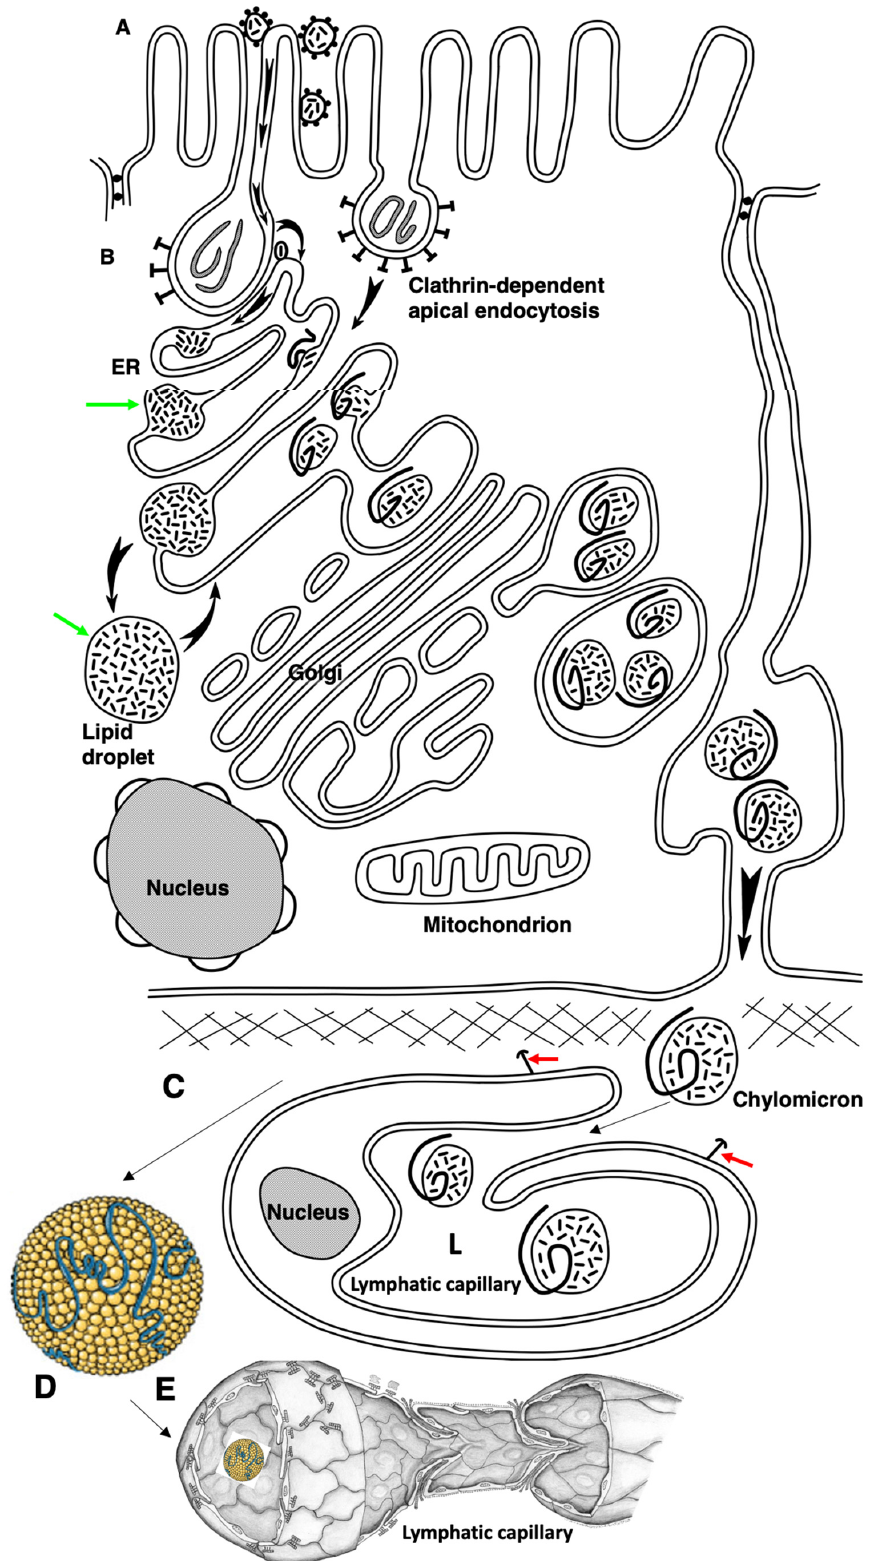
Figure 10. The hypothetical scheme of the lipid transcytosis in enterocyte of the newborn rats. ( A ) Micelles containing lipids and surrounded with bile acid molecules (black dots) passed through glycocalyx and contact with the apical plasma membrane of microvilli. Then FFAs and